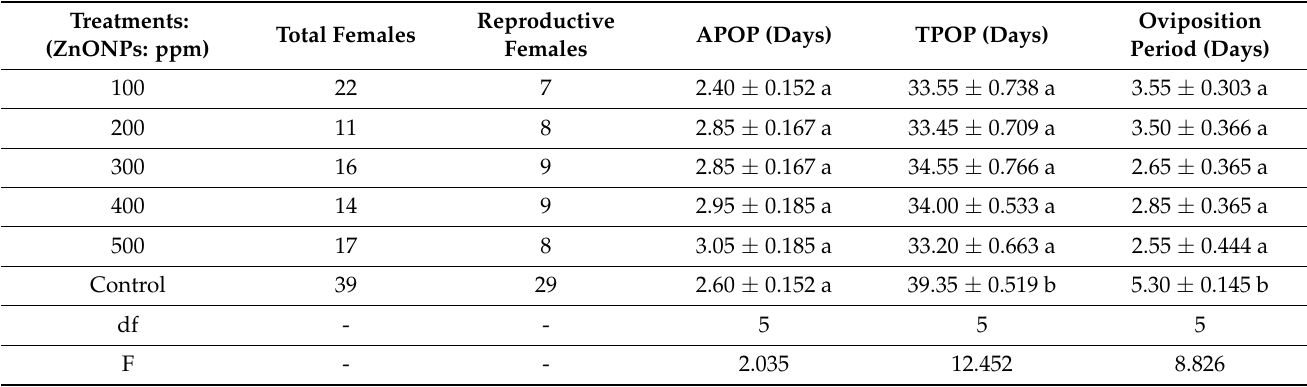
Table 4. Adult preoviposition period (APOP), total preoviposition period (TPOP), oviposition period, fecundity, and percent hatching parameters.